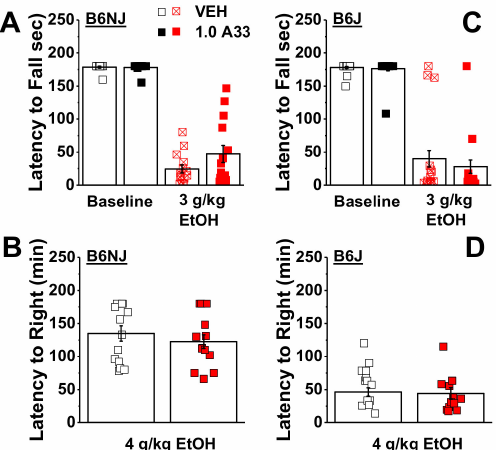
Figure 7. A33 does not affect motor coordination or the sedative–hypnotic properties of alcohol in A33/alcohol-experienced mice. Summary of the effects of pretreatment with either vehicle (VEH) or 1.0 mg/kg of A33 (1.0 A33) on ( A ) the latency of female and male B6NJ mice (8 females/7 males) to fall from a rotarod under an alcohol-free (Base; 30 min pretreatment) and alcohol-intoxicated state (3 mg/kg EtOH; ~75 min pretreatment). ( B ) Same as Panel A for female and male B6J mice (12 females/11 males). ( C ) Summary of the effects of VEH or A33 upon the time taken by B6NJ mice to regain their righting reflex following injection with 4 g/kg of alcohol. ( D ) Same as Panel C for B6J mice. The data represent the mean ± SEM of the aforementioned number of mice, in addition to the individual data points for each experimental